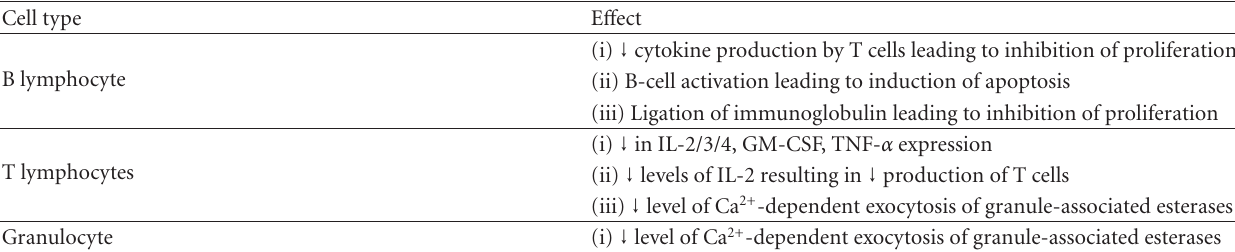
Table 2: E ff ect of CsA on leucocytes